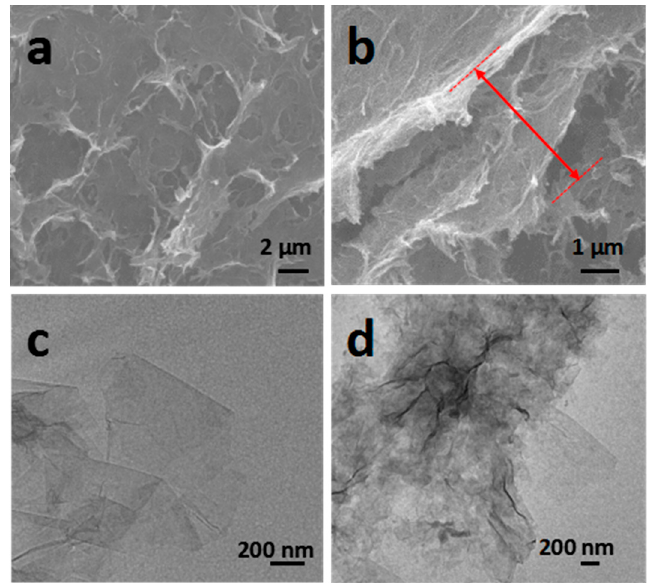
Figure 3. Morphological analysis of GO–BSA membranes: ( a ) SEM image of surface morphology of the GO–BSA film. ( b ) SEM image of the cross-section of the GO–BSA. ( c ) TEM image of surface morphology of the GO. ( d ) TEM image of surface morphology of the GO–BSA.